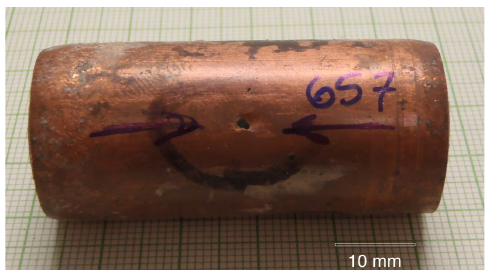
Figure 1. A typical pinhole leak in the copper